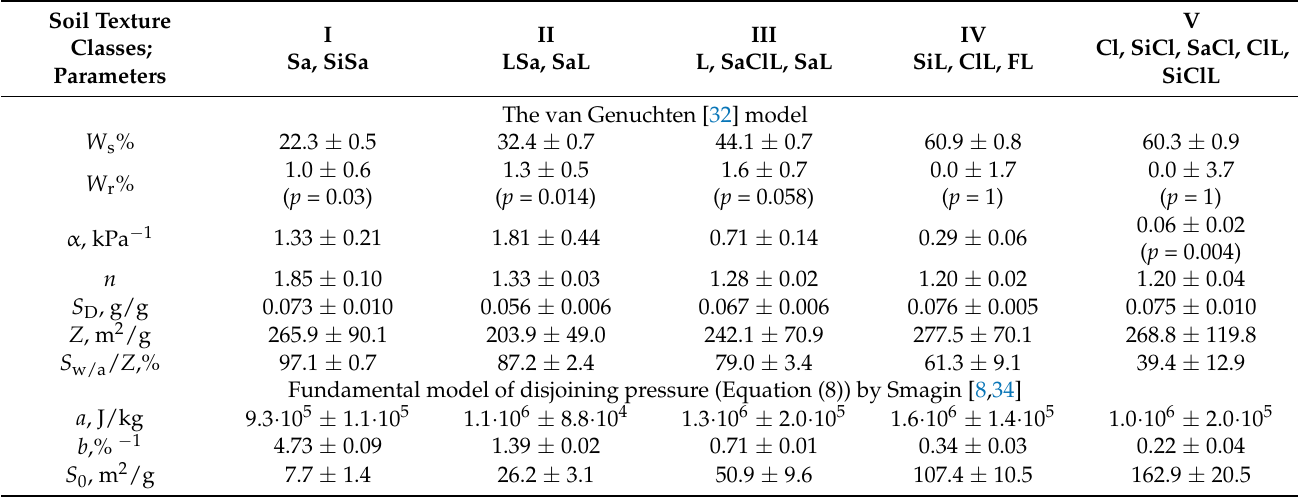
Table 1. Estimation of parameters in water retention and dispersity models for five groups of main textural classes of Eurasian